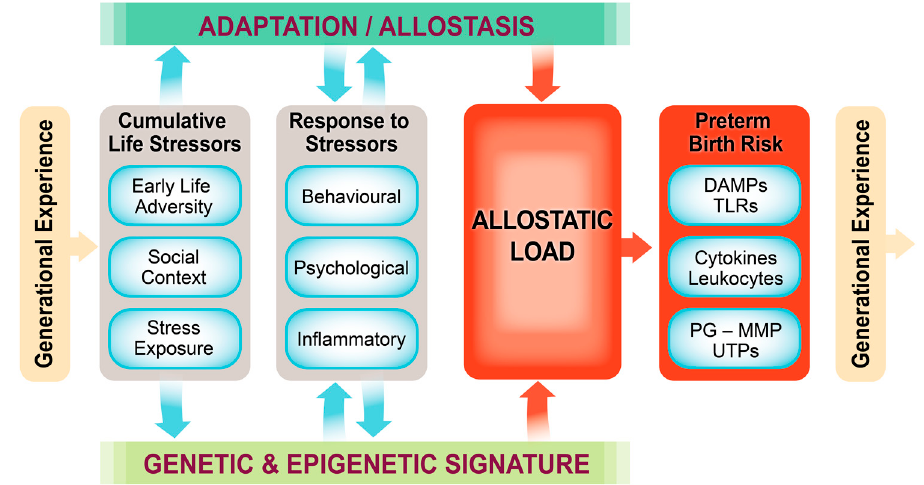
Figure 6. Conceptual framework linking transgenerational allostatic load and preterm birth. Building from the model of Saban et al. [69] and our own experimental data, we developed the Allostatic Load and Preterm Birth Conceptual Framework. This model provides a context for generational programming in connection with genetic and epigenetic signatures, multiple “hits” or stressors throughout the life course, downstream responses to these stressors leading to high allostatic load, and ultimately a sequence of distinct inflammatory and other mediator responses that lead to uterine activation, transformation and preterm birth (refer to Figure 5). The consequences of these effects are passed on to the next generation. See text for detailed description.